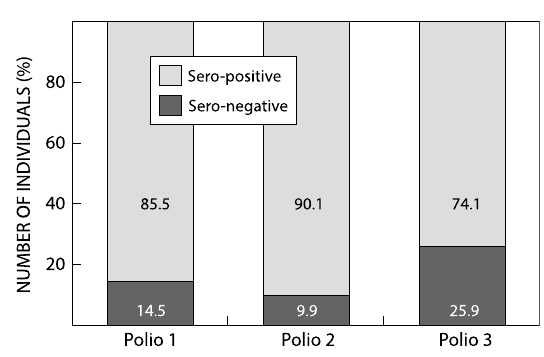
Figure 1: Seroprevalence of polio antibodies in employees of the National Institute for Communicable Diseases, 2009 –